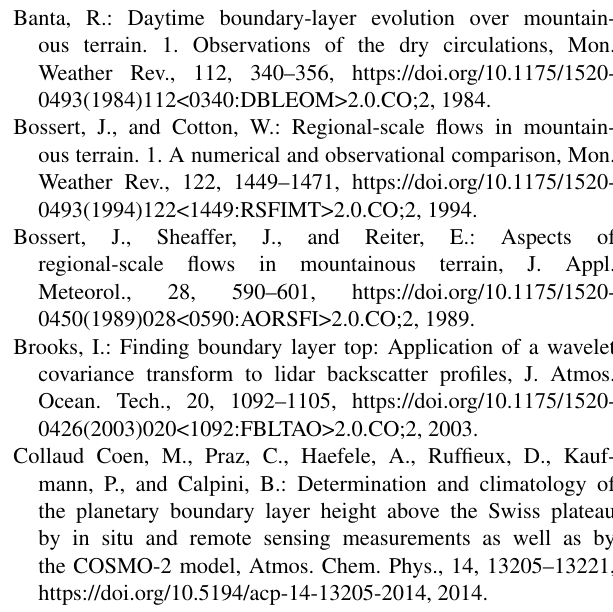
via aerosol backscatter in the current study. These influences should be made a consideration in future